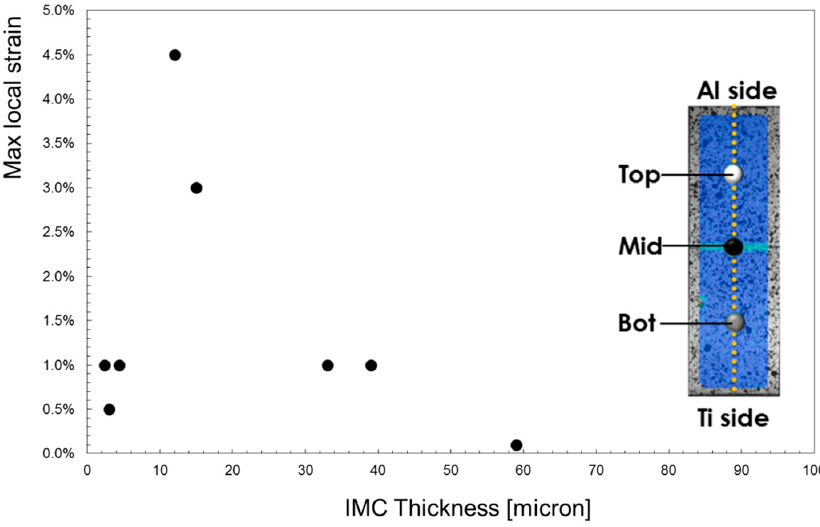
Figure 11. Strain levels reached in the region of the IMC layer.